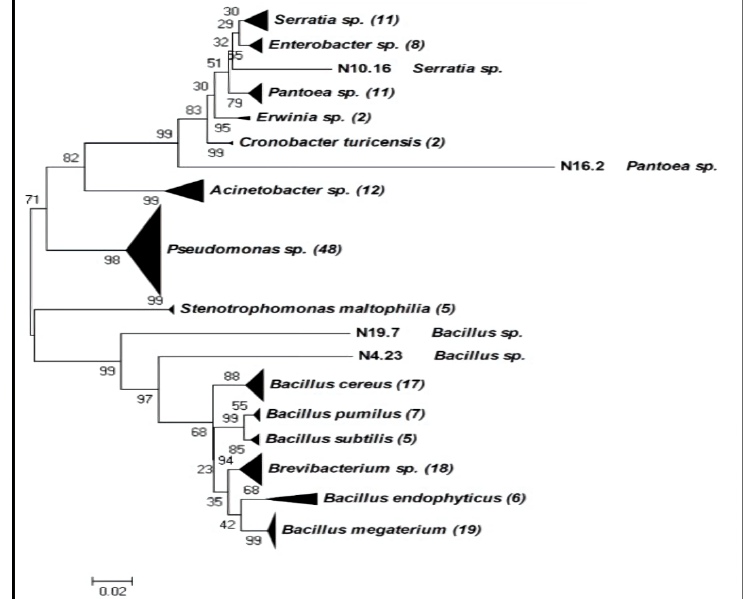
Figure 1. Phylogenetic tree performed with the 16S rRNA sequences. The evolutionary distances were inferred using the Neighbor-Joining method. The bootstrap consensus tree inferred from 1000 replicates was taken to represent the evolutionary history of the taxa analyzed. Annotation of bacteria included in the tree, were obtained from the NCBI (http://www.ncbi.nlm.nih.gov/). The number in brackets indicates number of species within each phylogenetic group.